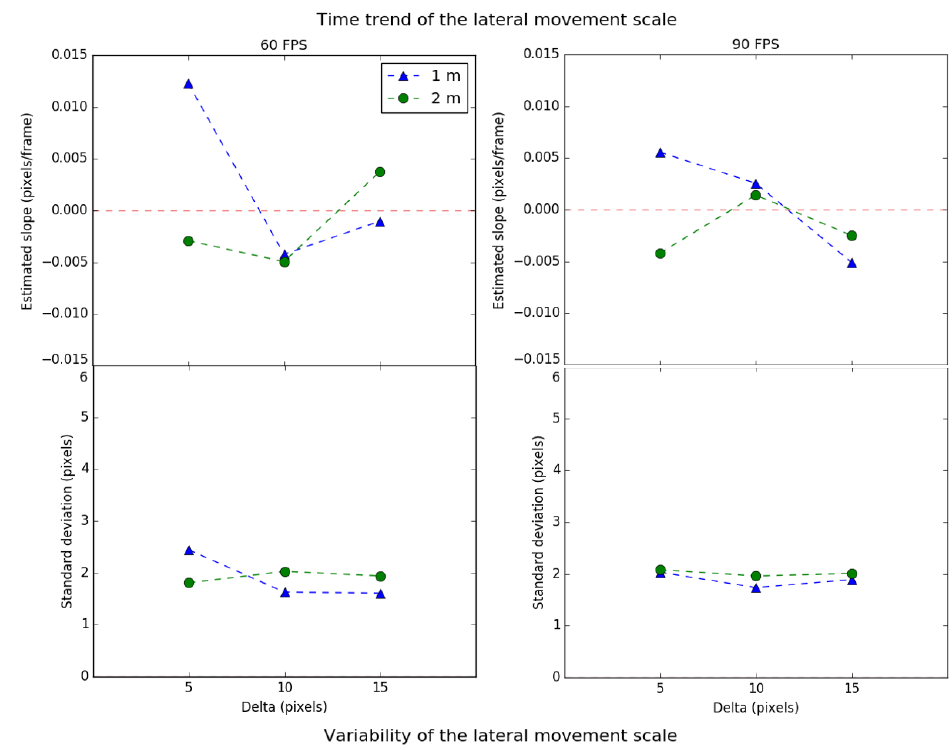
Figure 9. Time trend and variability of the scale for lateral movement.